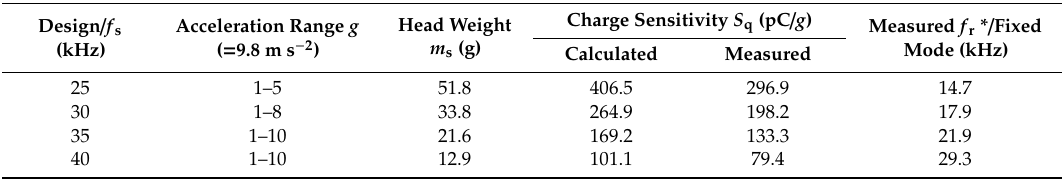
Table 4. Results of Pearson’s r , calculated and measured charge sensitivities S q , head weight m s and fixed resonant frequency f r for four optimized